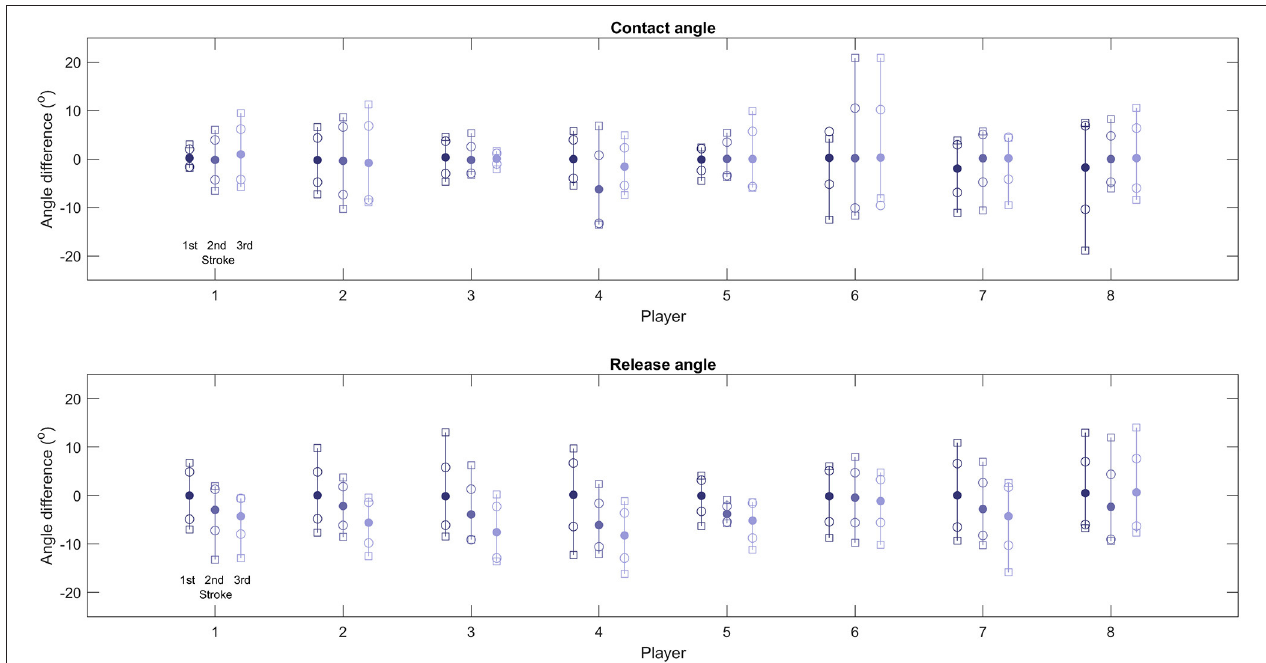
FIGURE 3 | Contact and release angle prediction differences from testing results. The first three strokes for each player are presented on individual bars, with each bar containing the mean difference (filled circle), the standard deviation (open circle), and minimum and maximum differences from testing results (open